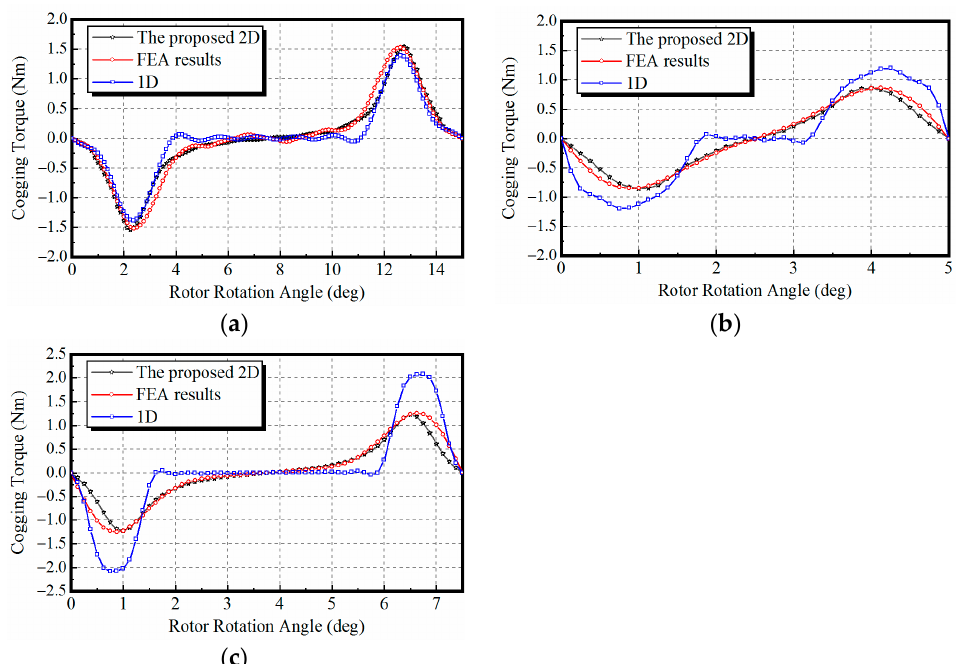
Figure 13. Comparison of FEA and analytical cogging torque waveforms, when pole-arc coefficient α = 0.63 , and slot-opening coefficient α = 0.18 : ( a ) 8P12S. ( b ) 8P36S. ( c ) 8P48S.